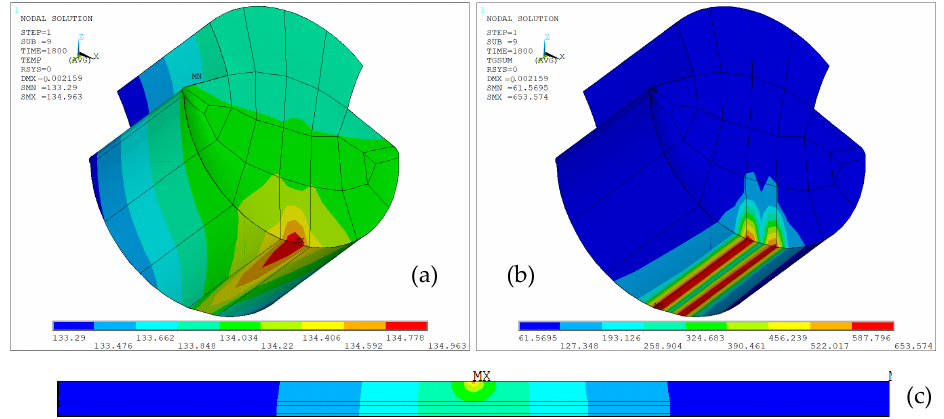
Figure 9. Temperature field in the cross-section of the contact wire and composite contact strip with the aluminum reinforcing bar.